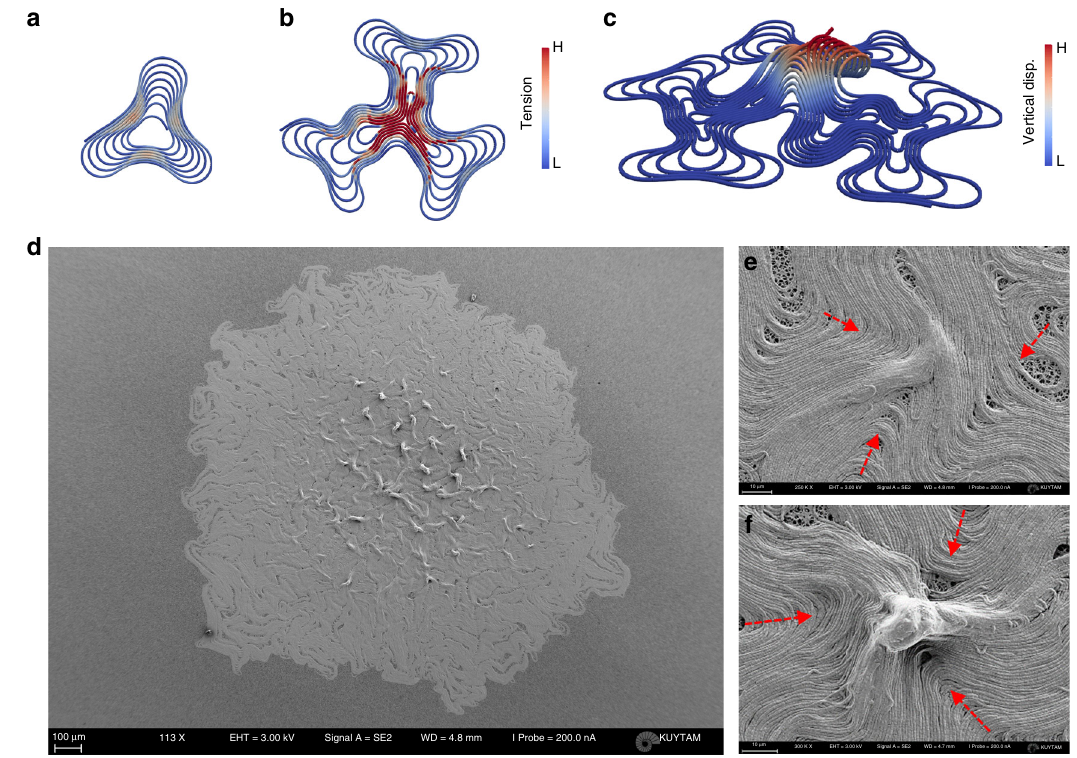
Fig. 5 Accumulation of stress and vertical liftoff. a – c Simulation results of a growing multilayered circular colony. a After reaching the critical radius, the colony folds and creates topological defects. b Inward-propagating defects collide and create a ( − 1/2) defect. The stress is accumulated at the collision point, which is a ( − 1/2) topological defect. c The accumulated stress results in vertical lifting around the ( − 1/2) topological defect. d – f SEM images of a bio fi lm in the late stage. Red arrows indicate the propagation directions of the defects. d Vertically lifted domains are in the vicinity of the center where the stress accumulates. e Motile ( + 1/2) defects collide and form a stationary ( − 1/2) defect. f Accumulation of stress causes vertical liftoff Table 1 Strain list used in this study Strain Parent Operation Genotype BAK47 168 Transformed with plasmid ECE321 from Bacillus Genetic Stock Center amyE:: Pveg-sfGFP (Spc) BAK50 TMN1152 Transformed with plasmid ECE321 from Bacillus Genetic Stock Center amyE:: Pveg-sfGFP (Spc) ywrK ::P spank - sinI (Spc) BAK51 Transformed with plasmid ECE321 from Bacillus Genetic Stock